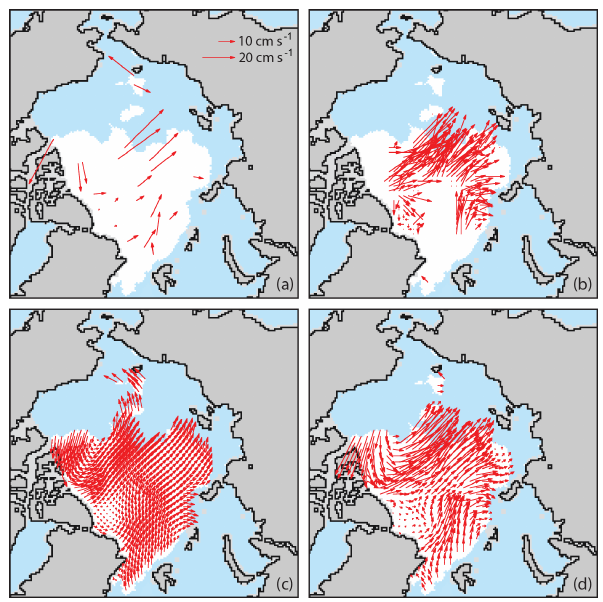
Figure 2. Daily motion vectors on 16 September 2016 from (a) buoys, (b) passive microwave, and (c) winds. The three sources are then merged to form (d) the daily interpolated sea ice motion field. Sea ice (white), ice-free ocean (blue), land (gray), and coast (black) are also shown. All buoys are shown, but other fields show only every fourth vector for legibility. In some years, AMSR-E or AVHRR also contributes